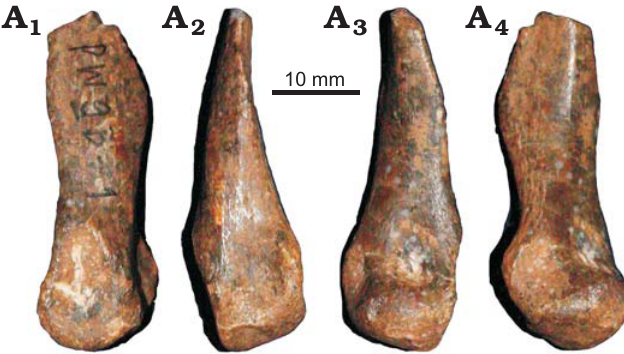
Fig. 11. Coelurosaurian theropod Phuwiangvenator yaemniyomi gen. et sp. nov. from the Early Creta ceous Sao Khua Formation of Phu Wiang, Khon Kaen Province, Thailand. SM-PW9B-1, left metatarsal I in lateral (A 1 ), posterior (A 2 ), anterior (A 3 ), and medial (A 4 )